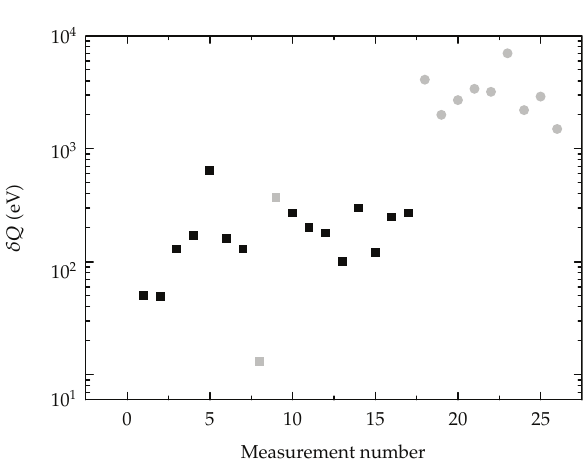
Figure 3: Uncertainty in the Q -values measured with Penning traps (cid:3) filled squares (cid:4) and from the latest published version of the Atomic Mass Evaluation (cid:3) AME (cid:4) (cid:5) 59 (cid:6) (cid:3) filled circles (cid:4) . The squares in black and grey represent the results obtained using the tof and the IIC technique, respectively. The characteristics for the decays with the Q -values represented by filled circles are listed in Table